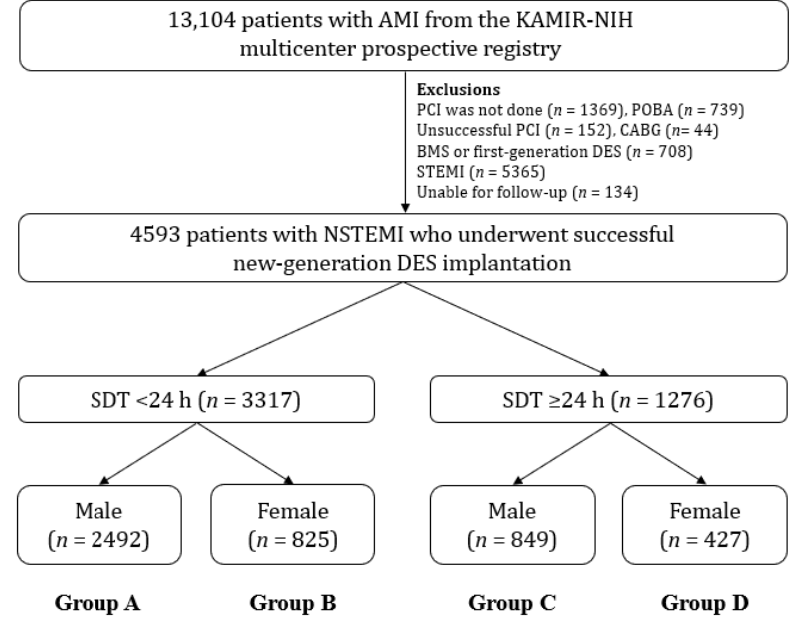
Figure 1. Flowchart. AMI, acute myocardial infarction; KAMIR-NIH, Korea Acute Myocardial Infarction Registry-National Institute of Health; PCI, percutaneous coronary intervention; POBA, plain old balloon angioplasty CABG, coronary artery bypass graft; BMS, bare-metal stent; DES, drug-eluting stent; STEMI, ST-segment-elevation myocardial infarction; NSTEMI, non-STEMI; SDT, symptom-to-door time.